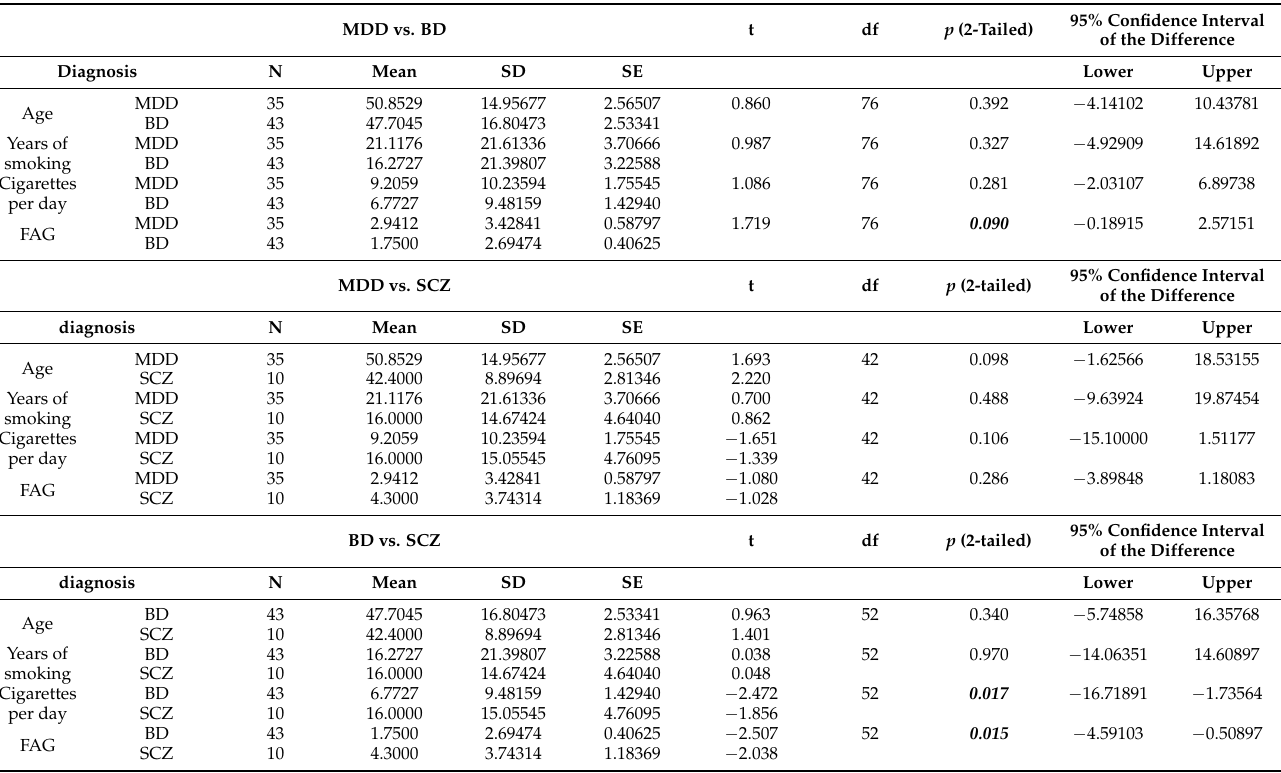
Table 1. Socio-demographics and clinical characteristics of the studied sample.